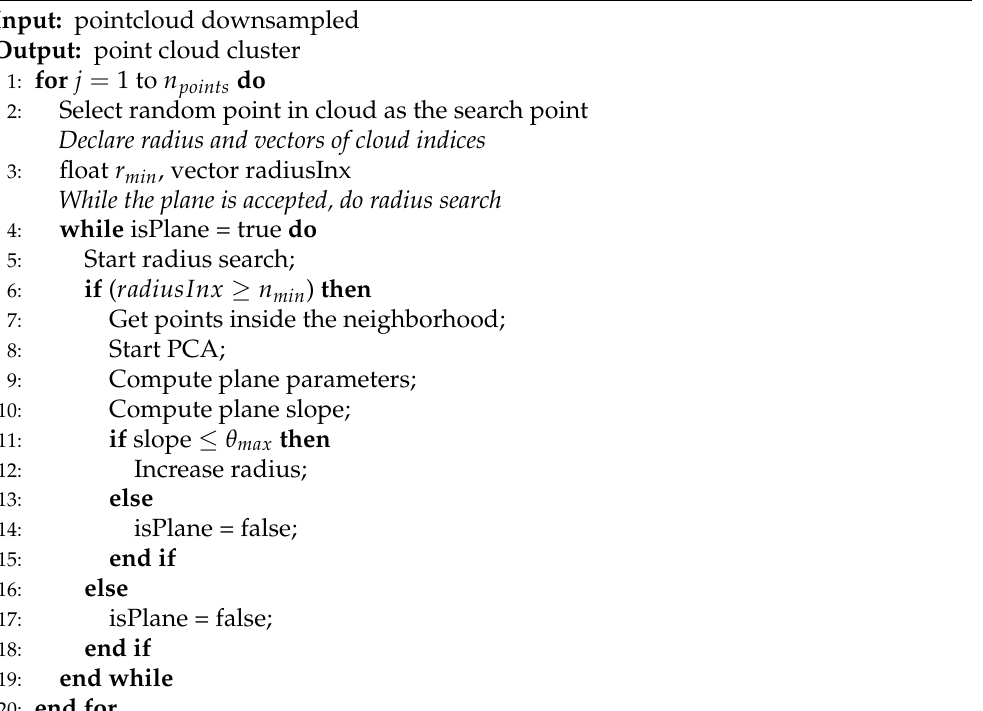
Algorithm 1 Algorithm for neighborhood and plane identification steps.